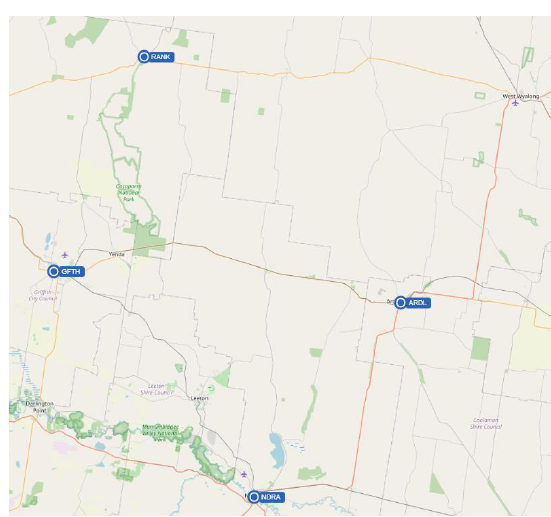
Figure 5 : Proximity of Leeton test site and Griffith test site to CORS